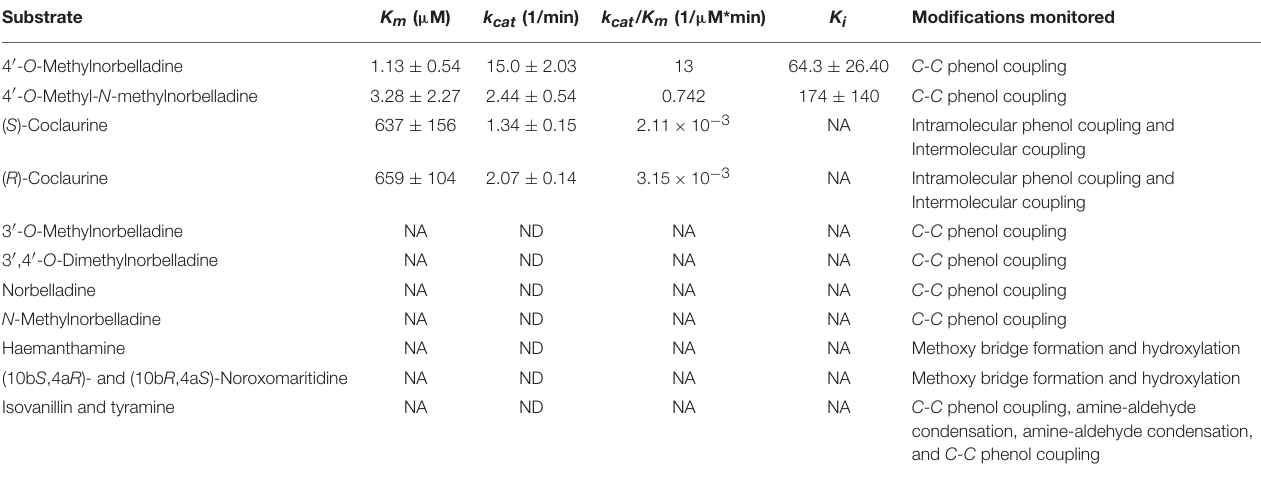
TABLE 5 | Substrate specificity tests for